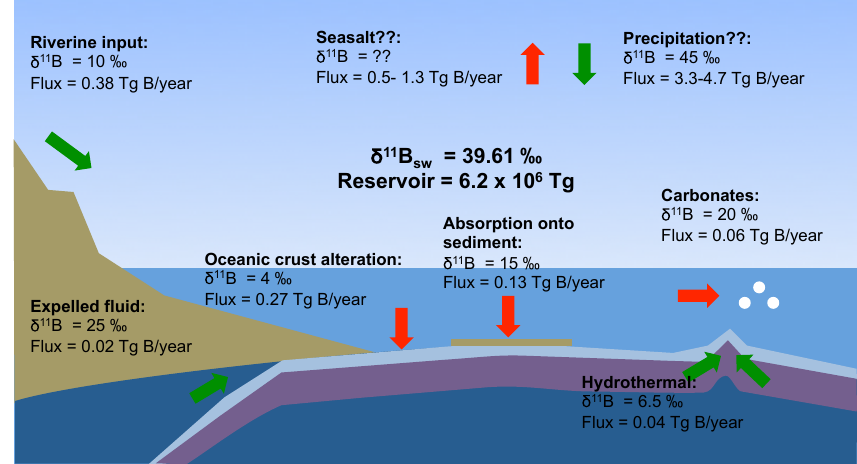
Figure 1. The oceanic boron cycle. Fluxes are from Lemarchand et al. (2000) and Park and Schlesinger (2002). Isotopic compositions are from Lemarchand et al. (2000), Foster et al. (2010) and references